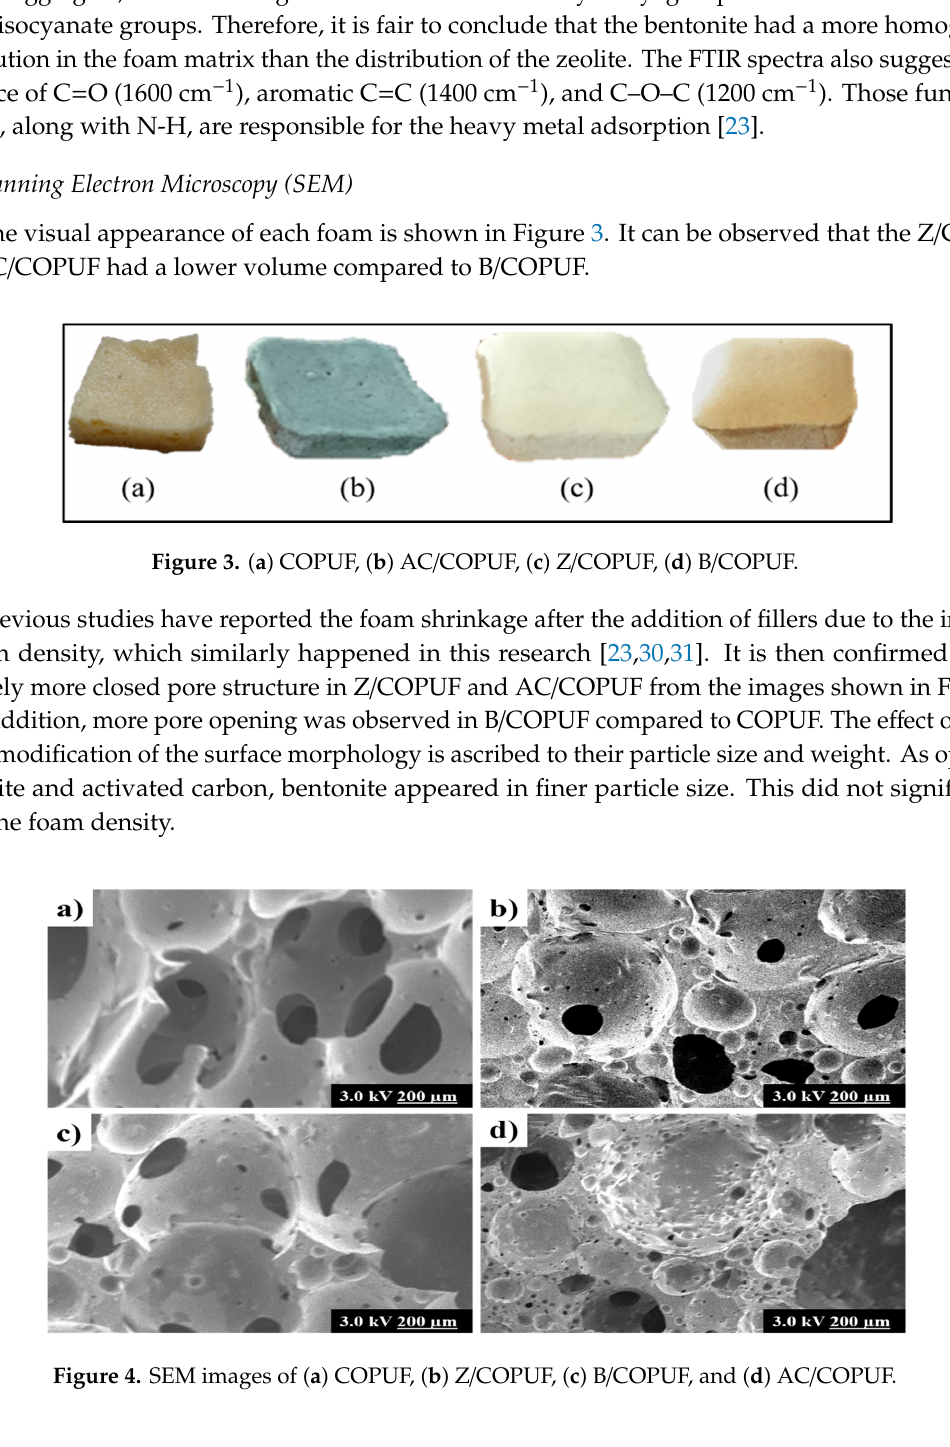
Figure 4. SEM images of ( a ) COPUF, ( b ) Z/COPUF, ( c ) B/COPUF, and ( d ) AC/COPUF.